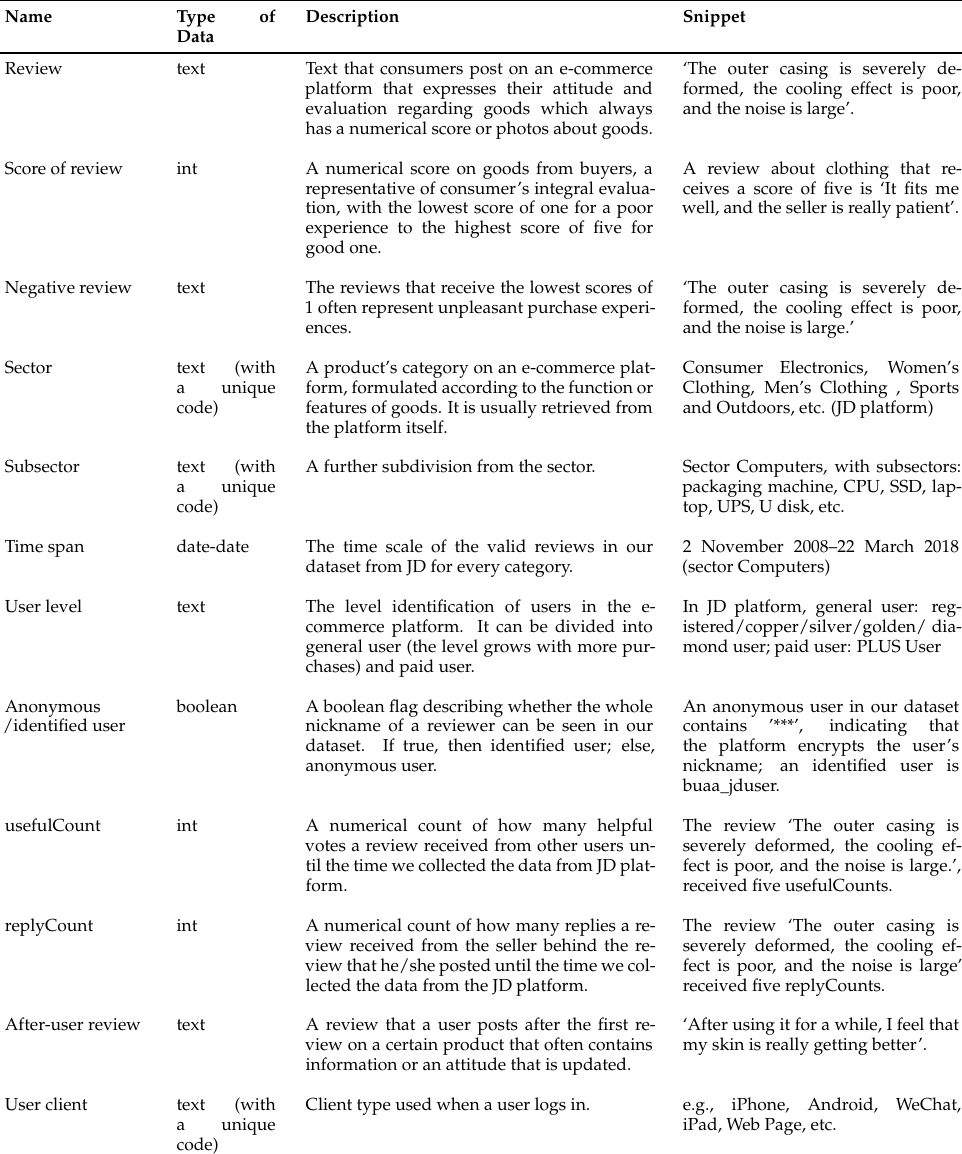
Table A1. A brief description of the attributes of our